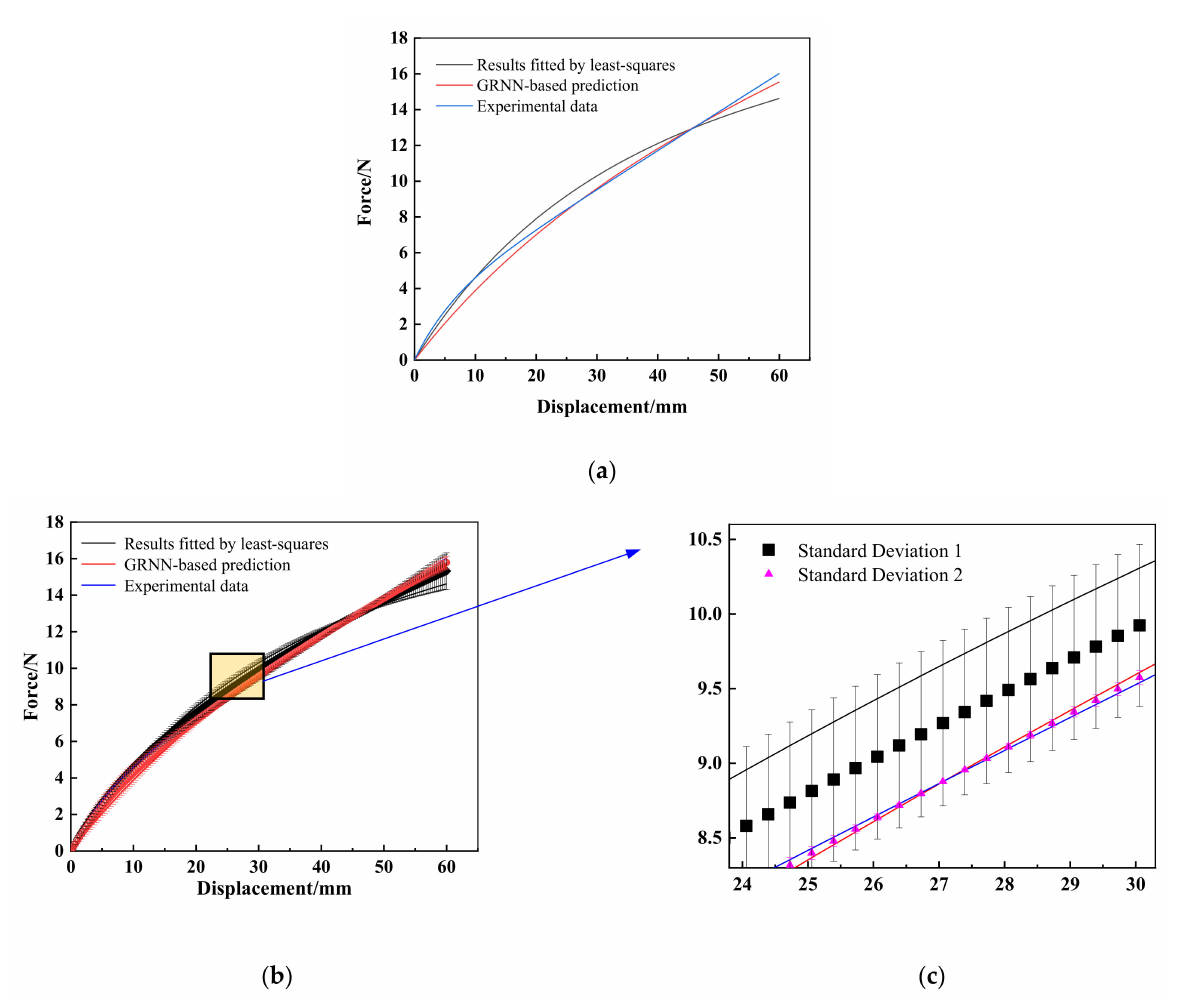
Figure 9. Results obtained by using M–R model. Here, if the mean value of least-squares and the experimental data is defined as MV1, then, the differences between MV1 and force-displacement data fitted by least- squares, marked as standard deviation 1 (black square), can reflect the closeness of the least-squares results to the experimental data. Similarly, the values of standard deviation 2 (magenta triangle) represent the difference between MV2 (the mean values of GRNN- based prediction and experimental data) and GRNN-based prediction. The smaller the standard deviation (one or two) value, the closer the sample results (least-squares or GRNN- based prediction) and experimental data. Furthermore, from the partial enlargement presented in Figure 9c, it is clear to see that the lengths of the error bars associated with least-squares are obviously longer than those calculated by GRNN-based prediction, that is, the values of standard deviation 1 are larger than standard deviation 2, e.g., the maximum values of standard deviation 1 and 2 are 0.9912 and 0.5366, respectively. The results indicate that the force-displacement curve obtained from GRNN-based prediction is closer than those fitted by least-squares method to the experimental force-displacement curve.